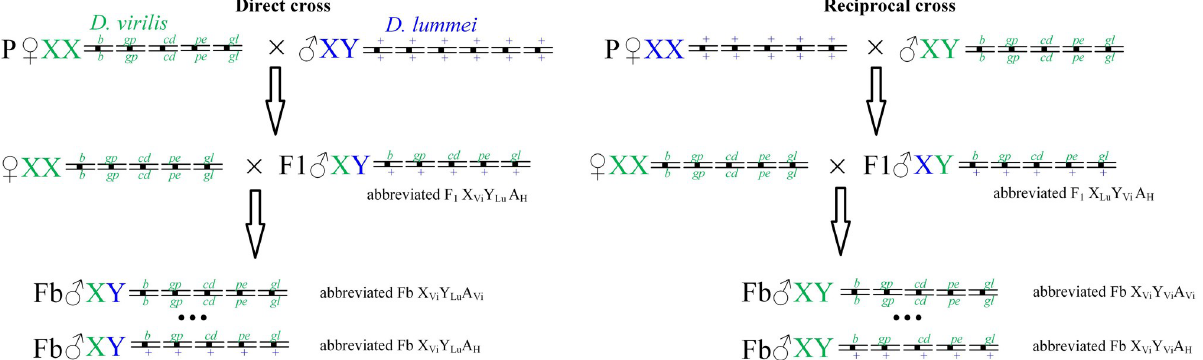
Fig 1. The scheme of direct ( D . virilis × D . lummei ) and reciprocal ( D . lummei × D . virilis ) crosses. Backcrosses were accomplished by the crossing of F 1 hybrid males with D . virilis females. Chromosomes of D . virilis are designated with green, and chromosomes of D . lummei are designated with blue. The three dots in Fb males designate all possible intermediate autosome genotypes between the full homozygotes for the marker mutations ( b / b gp / gp cd / cd pe / pe gl / gl ) and full heterozygotes for the marker mutations ( b / + gp / + cd / + pe / + gl / +